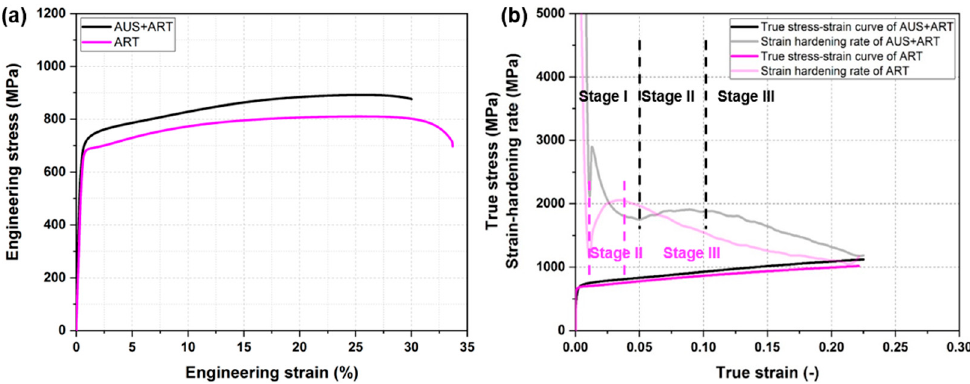
Figure 5. ( a ) Engineering stress-engineering strain curves; ( b ) true stress-true strain curves and strain- hardening curves of the medium-Mn steel Fe-12Mn-3Al-0.05C after heat treatment austenite- reverted-transformation (ART) and AUS +